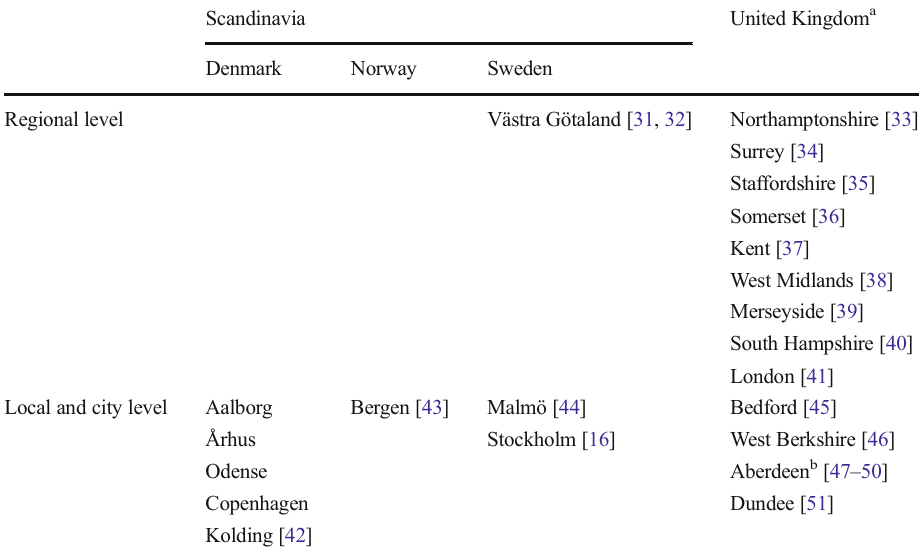
Table 1 Urban freight plans categorised by geographical level